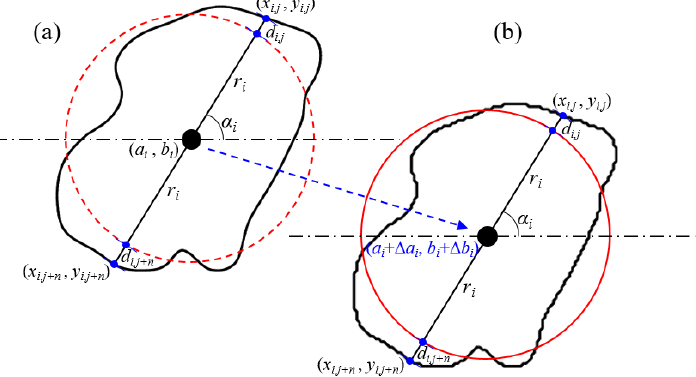
Figure 6. The principle of grain position change. ( a ) Original relationship between grain boundary and mapping circle. ( b ) The relationship between them with the coordinates increasing Δ a i and Δ b i .